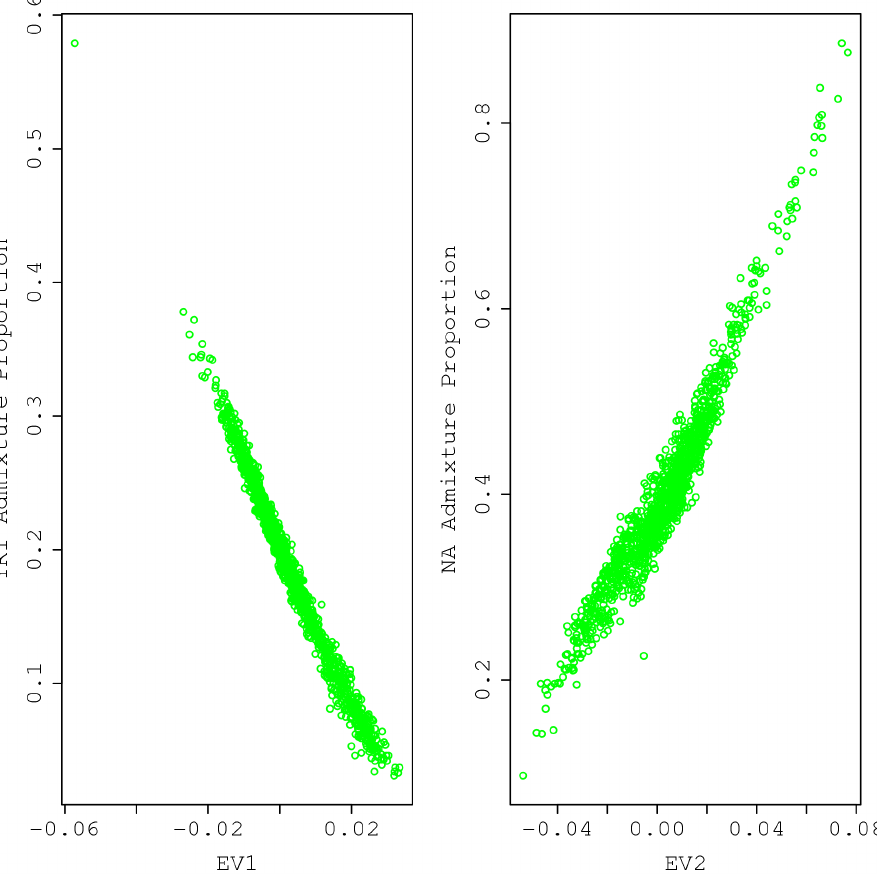
Figure 5. Correlation between STRUCTURE admixture coefficients and PCA eigenvectors for CR samples. Both STRUCTURE analysis and PCA are based on the same data set as detailed in the legend of Figure 4. Pearson correlation coefficients are 2 0.99 for CEU admixture proportion versus EV1 (left panel) and 0.96 for NA admixture proportion versus EV2 (right panel).